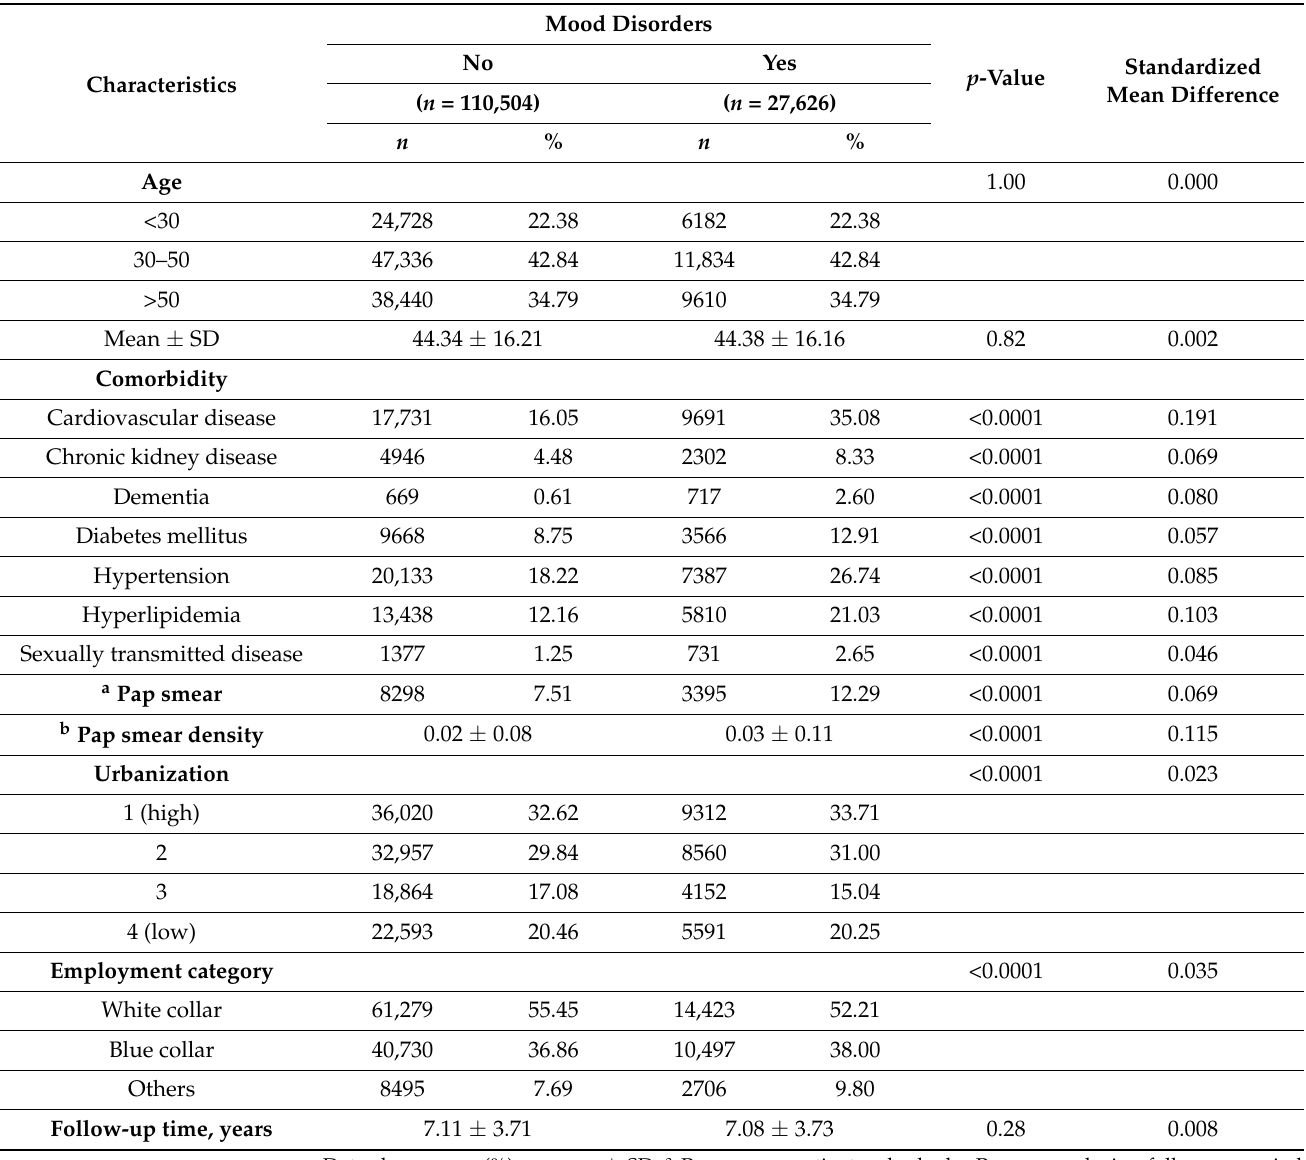
Table 1. Baseline characteristics of